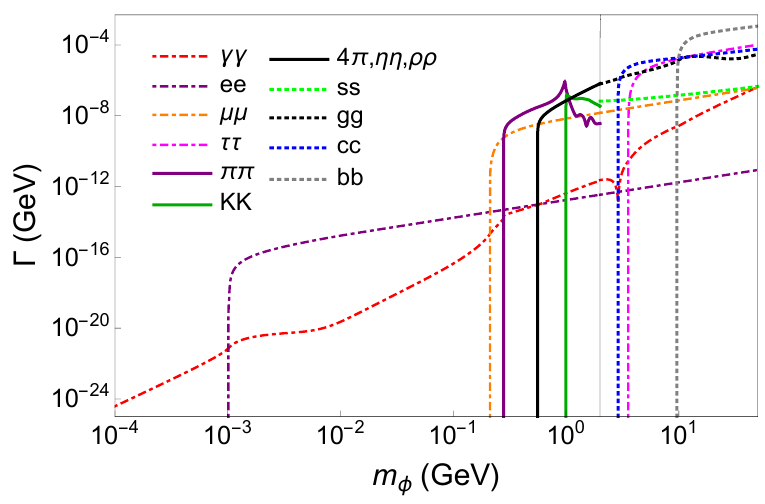
Figure 1 . Partial widths of the mediator decaying into SM particles assuming sin θ = 1